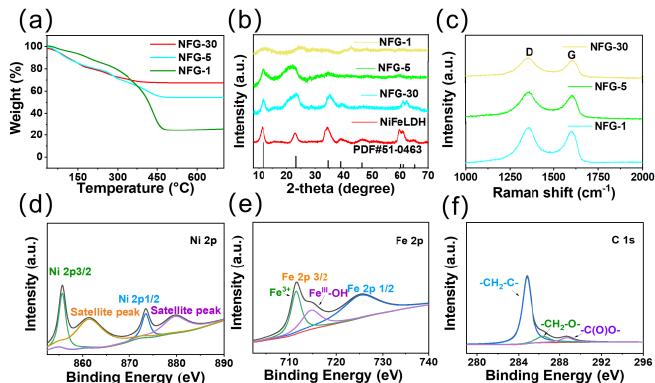
Figure 1. ( a ) TGA curves of NFG-1, NFG-5, and NFG-30, ( b ) XRD patterns of NFG-1, NFG-5, NFG-30, and NiFeLDH, and ( c ) Raman spectra of NFG-1, NFG-5, and NFG-30, respectively. High resolu-